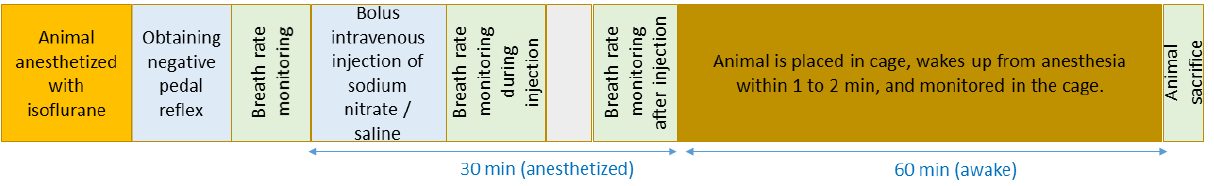
Figure 1. A scheme of the experimental workflow.